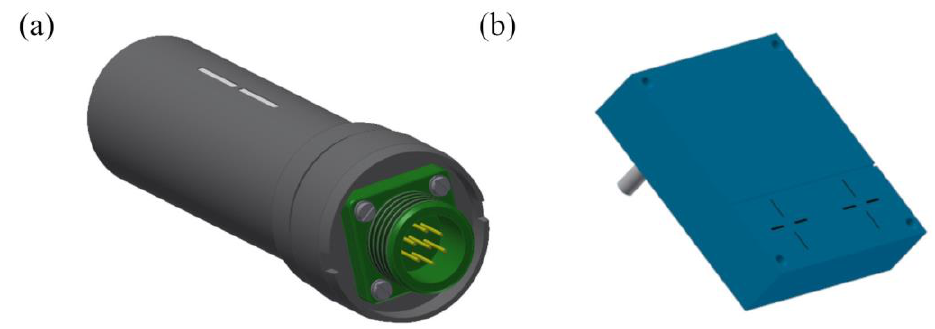
Figure 4. 3D visualization of the ( a ) ZR-1 dosimetric probe and ( b ) ZR-2 dosimetric probe. The signaling device detection system can detect gamma radiation after exceeding an absorbed dose rate of 5 μGy/h.